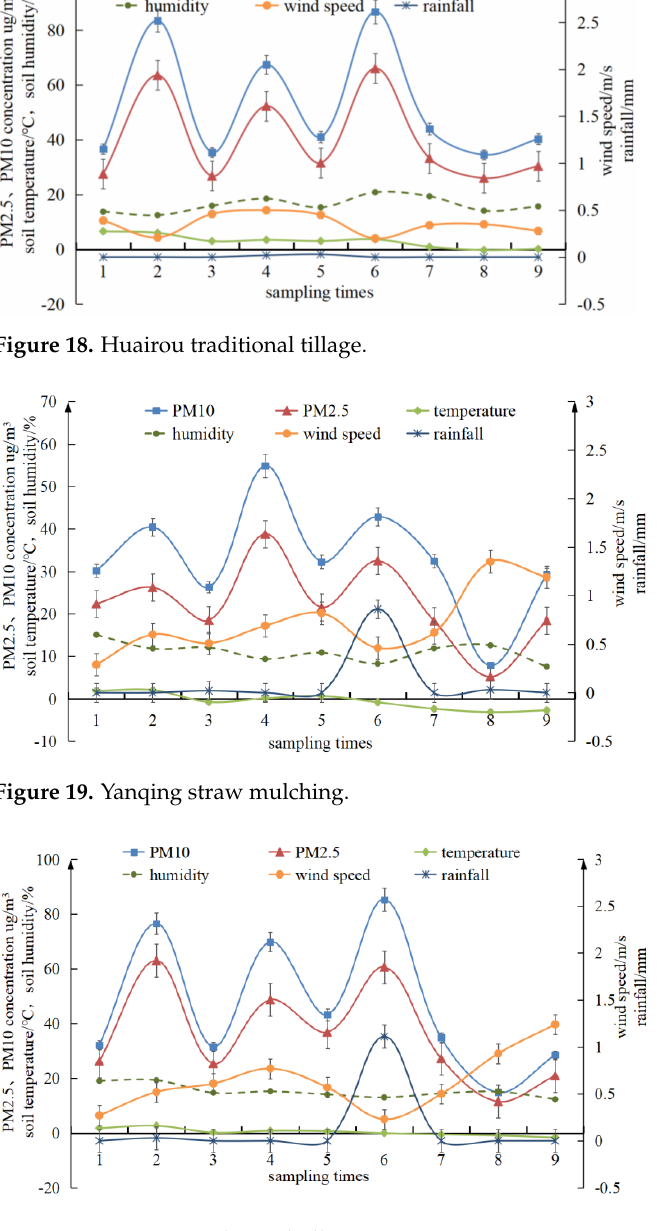
Figure 20. Yanqing traditional tillage.